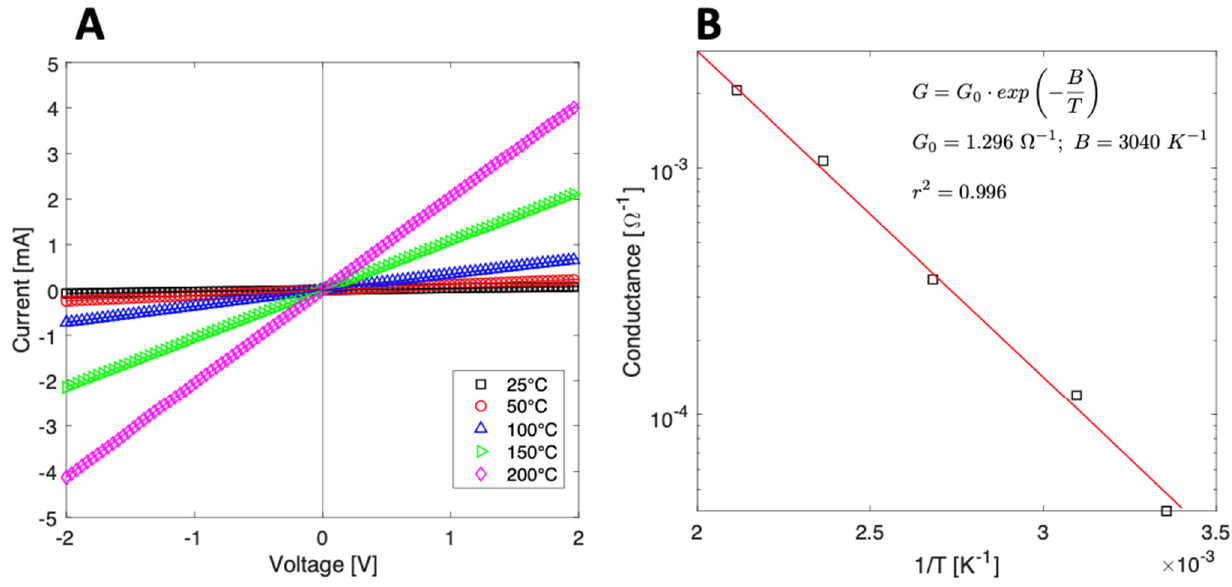
Figure 8. ( A ) I–V curves from V 2 O 5 nanosheets measured at different working temperatures; ( B ) Arrhenius plot: conductance vs. the inverse of temperature.